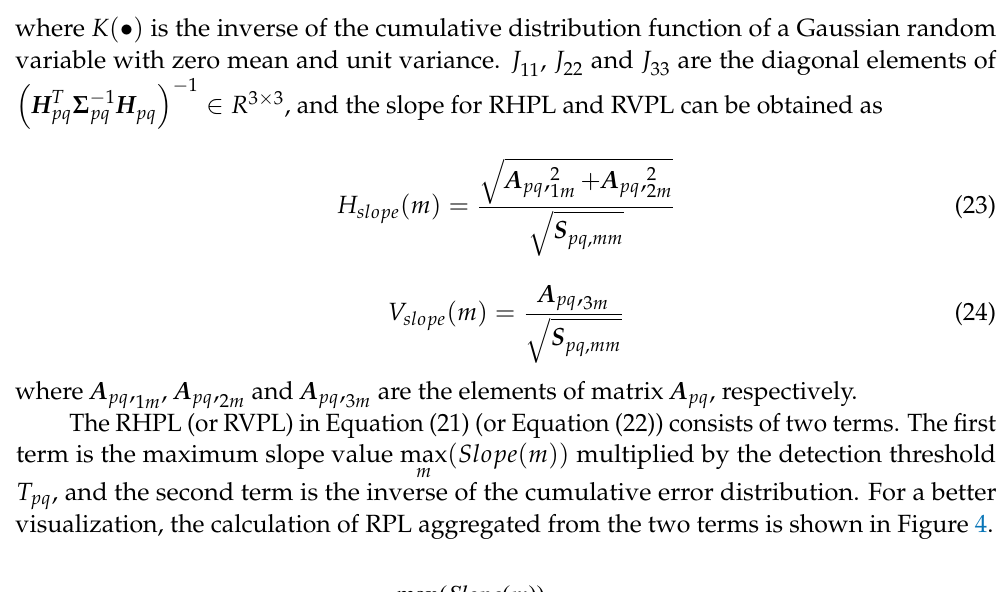
visualization, the calculation of RPL aggregated from the two terms is shown in Figure 4.